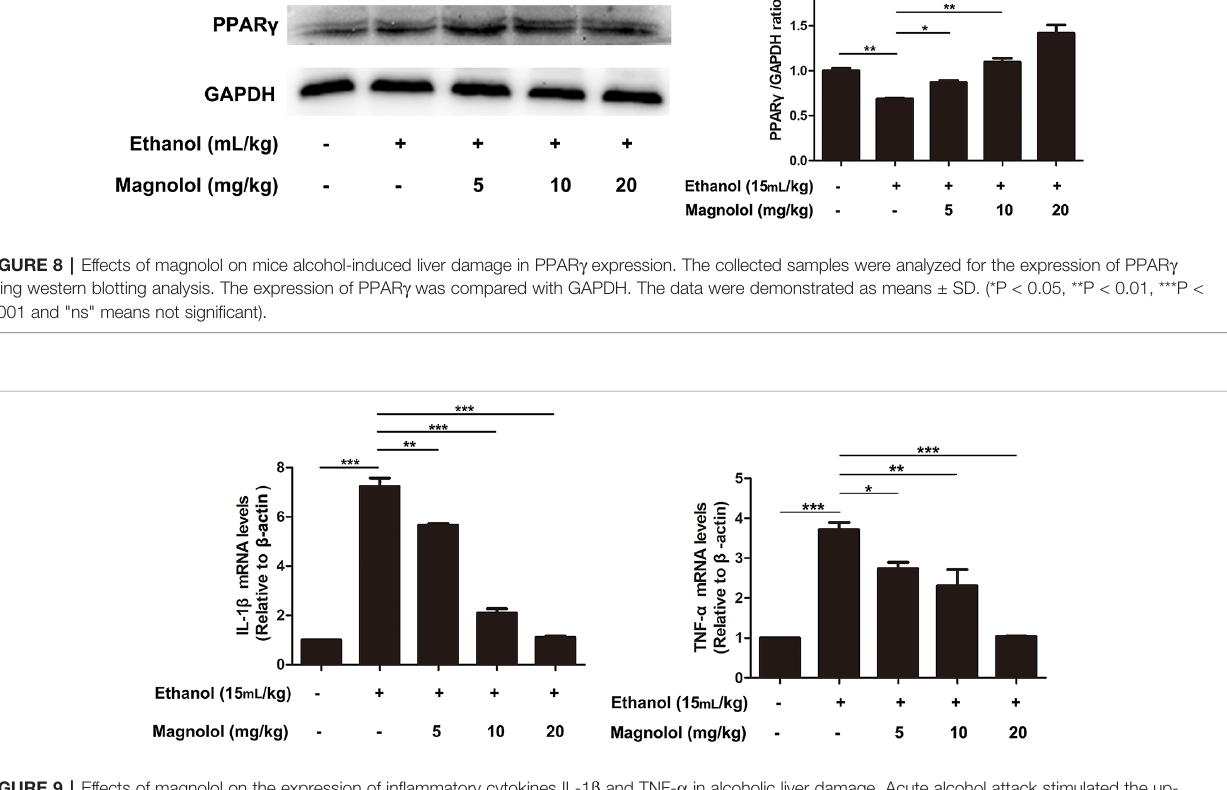
FIGURE 9 | Effects of magnolol on the expression of in fl ammatory cytokines IL-1 b and TNF- a in alcoholic liver damage. Acute alcohol attack stimulated the up- regulation of TNF- a and IL-1 b at mRNA measured by q-RT PCR analysis. Magnolol pretreatment signi fi cantly inhibited the up-regulation of TNF- a and IL-1 b in ALD mice. The data is presented as mean ± SD. (*P < 0.05, **P < 0.01, ***P <